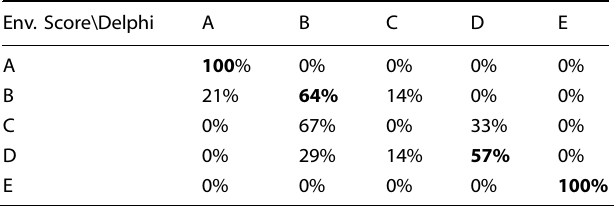
Table 3. Contingency table showing agreement between expert categorization (Delphi results) and Enviroscore.